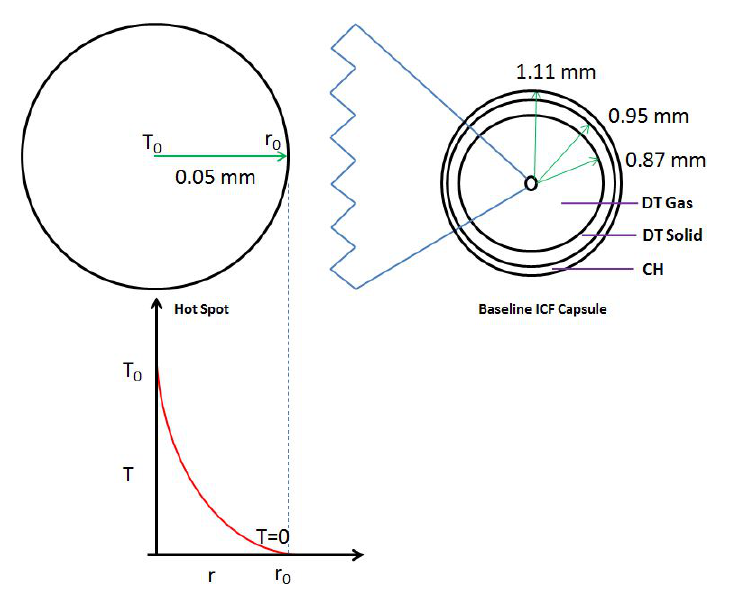
Figure 2. Illustration of a typical ICF physical model for the National Ignition Facility.